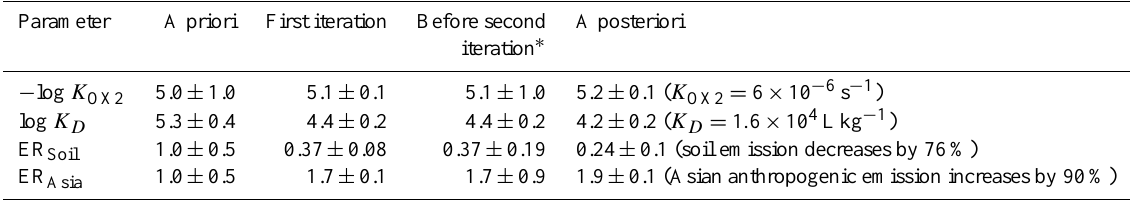
Table 4. Evolution of the parameters’ estimates in the parameter inversion.